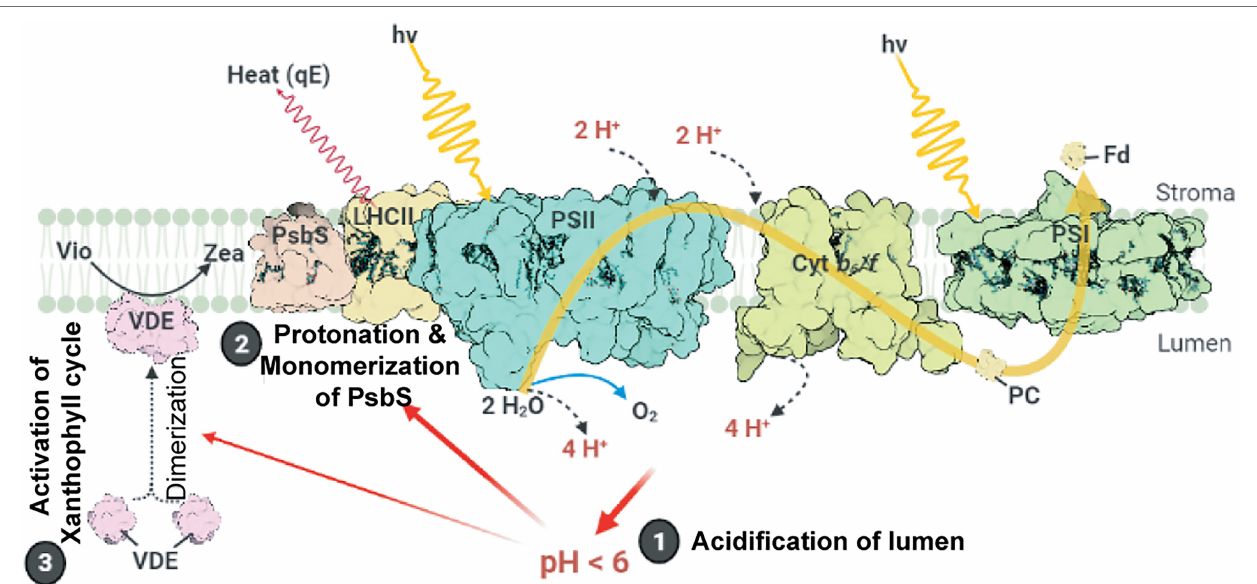
FIGURE 1 | Schematic model of qE induction in higher plants. Photosystem II (PSII), cytochrome b6f (Cyt b 6 f ), photosystem I (PSI), light-harvesting antenna complex II (LHCII), plastocyanin (PC), and ferredoxin (Fd) are shown. Light-induced ∆ pH formation (lumen acidification) results from the oxidation of water at the oxygen evolving complex (OEC) in PSII and proton (H + ) translocation during the Q cycle in Cyt b 6 f . Low luminal pH induces the protonation and monomerization of PsbS and activates violaxanthin de-epoxidase to convert violaxanthin (Vio) to zeaxanthin (Zea). Also, low luminal pH induces the aggregation of LHCII (for details, see text). These LHC conformational changes finally lead to the thermal dissipation of excess energy via the LHCs. This figure was designed using the BioRender web server